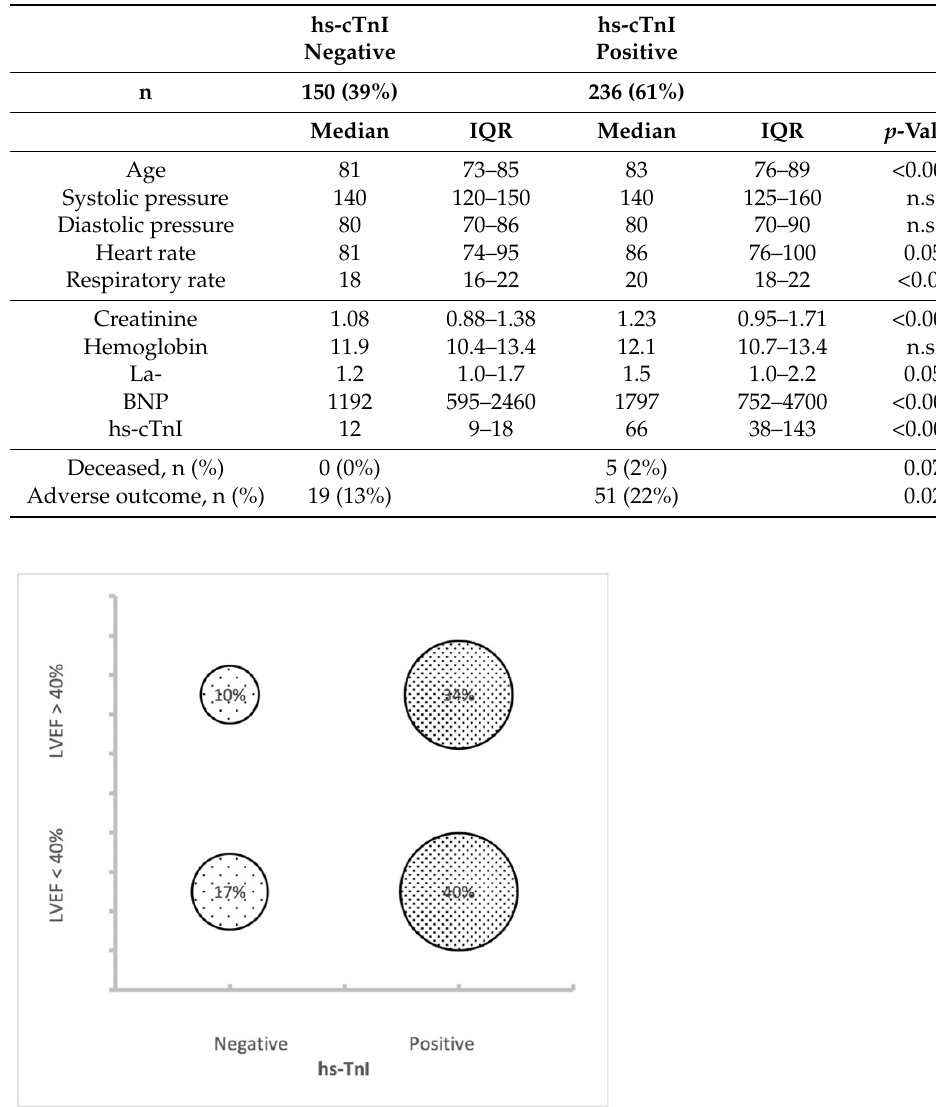
Table 3. Results according to hs-cTnI test.